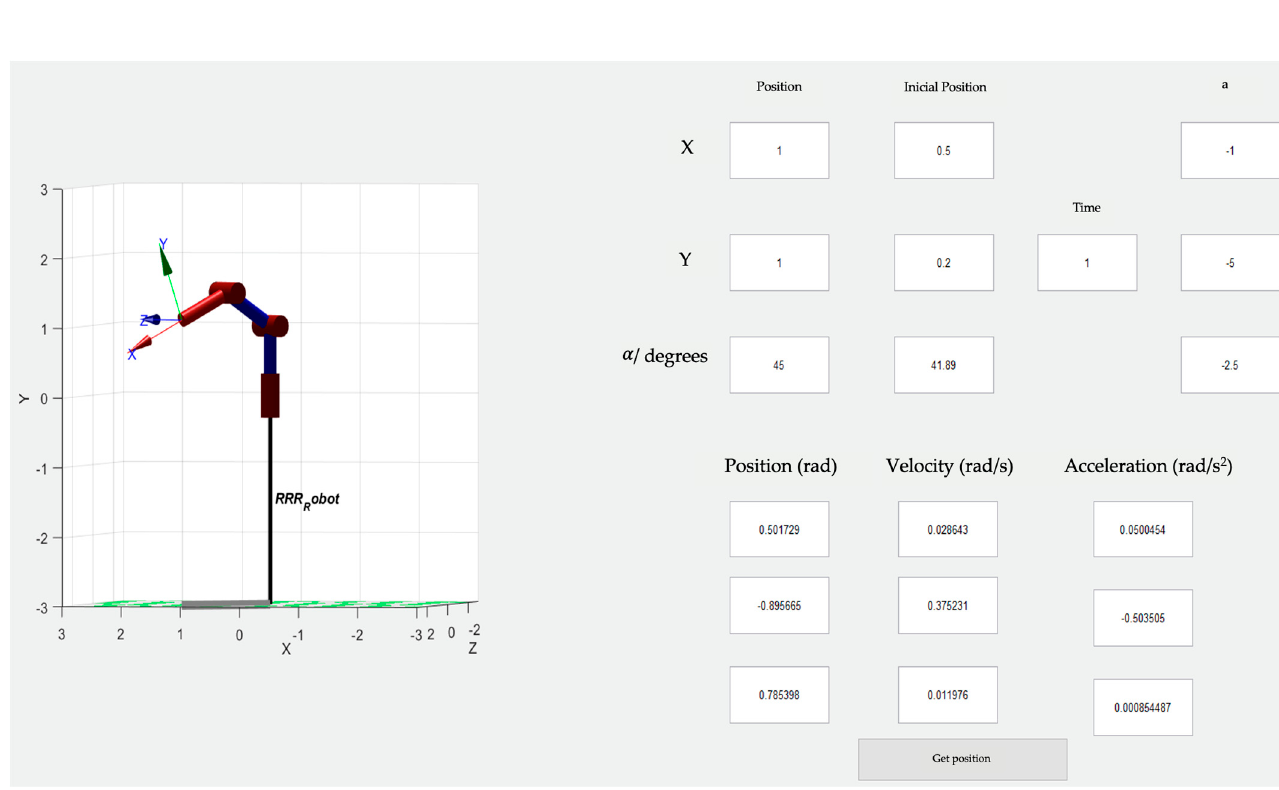
Figure 9. Guide of MATLAB, where the final position (rad), velocity (rad/s) and acceleration (rad/s 2 ) values are shown, and the trajectory is seen with the joint position commands.